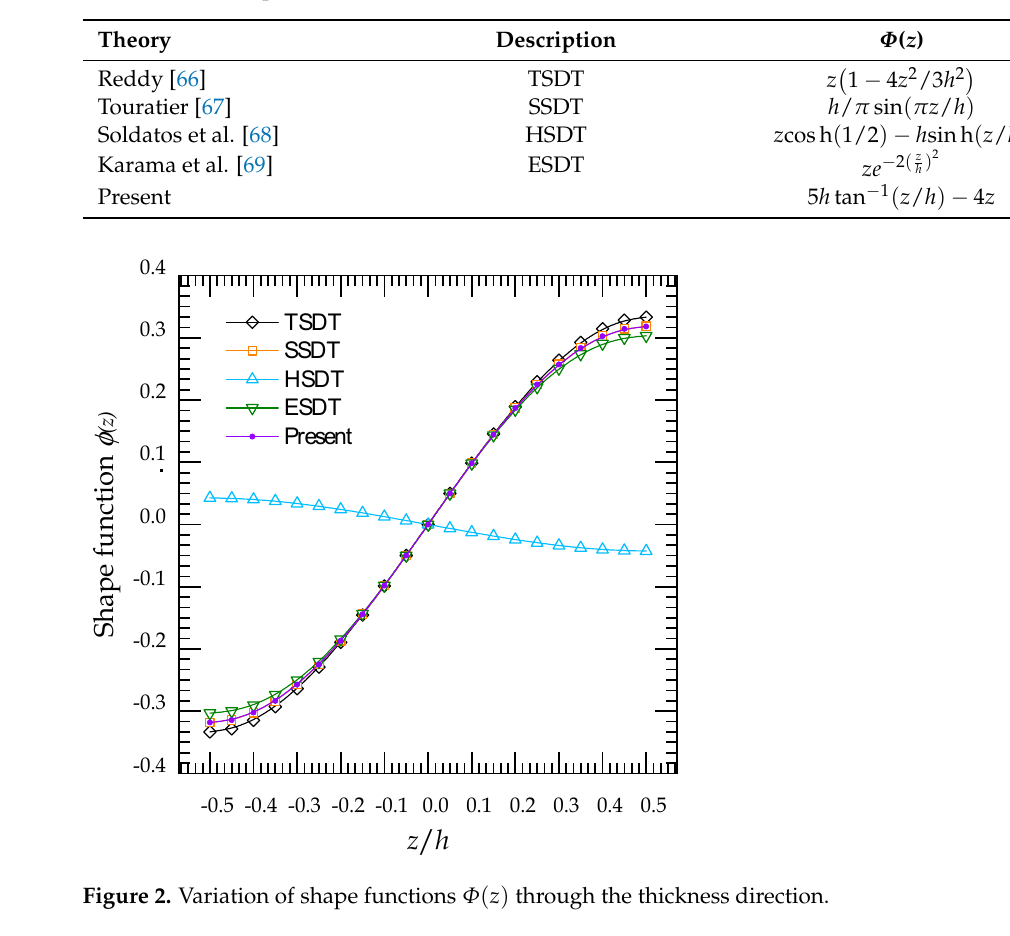
Table 1. Shear shape function distribution.